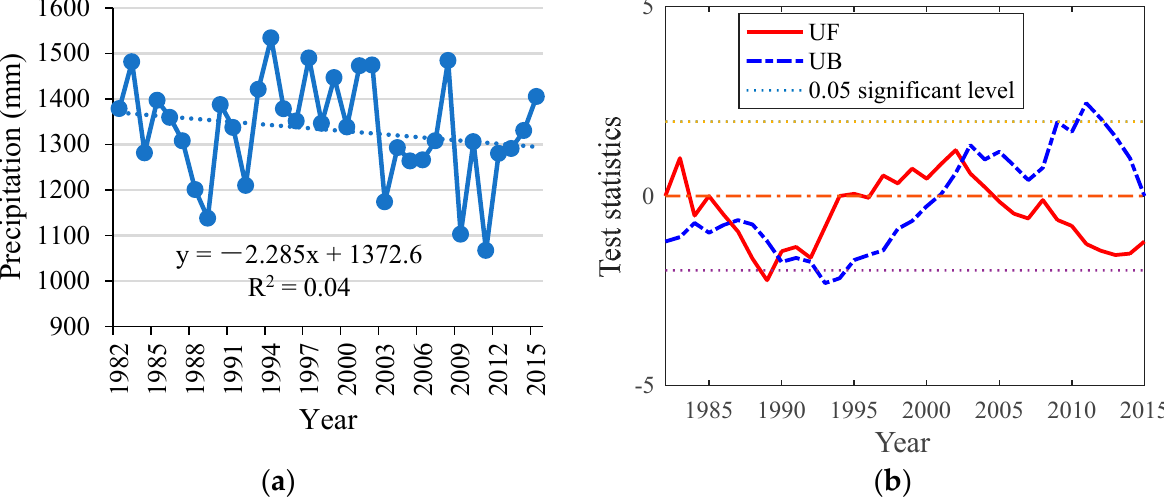
Figure 3. The temporal variation ( a ) and mutation detection ( b ) of the annual mean precipitation in the karst areas of Southwest China from 1982 to 2015.